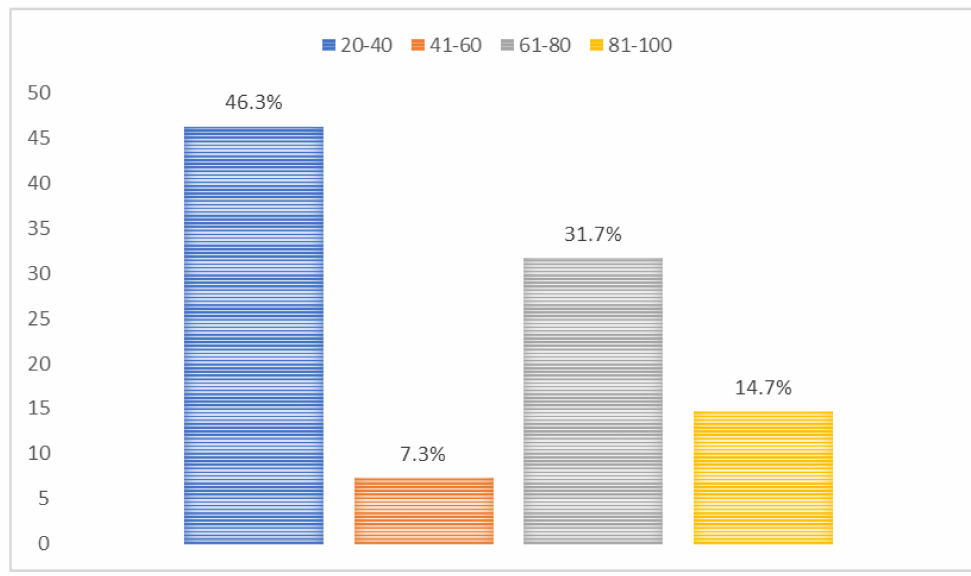
Figure 2. Usability of mHealth apps on a scale from 20 to 100. Table 3. Factors associated with mHealth app usability among mHealth app users ( n =